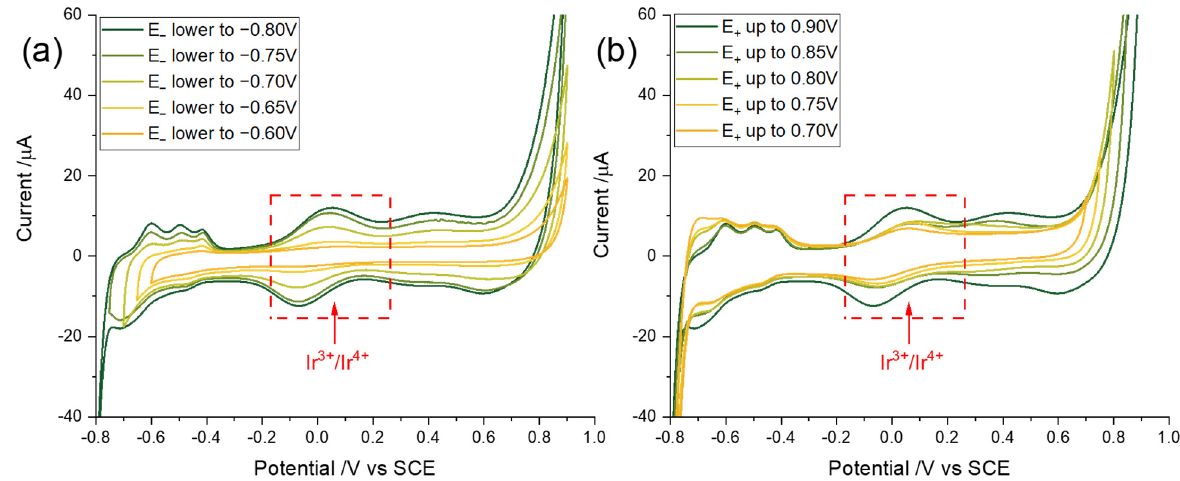
Figure 3. Cyclic voltammograms of the 40th cycle SCE in air-saturated synthetic seawater with pH = 8.14 starting at a potential of − 0.2 V for activation of an Ir wire with different ( a ) cathodic and ( b ) anodic potentials at a scan rate of 0.5 Vs − 1 .